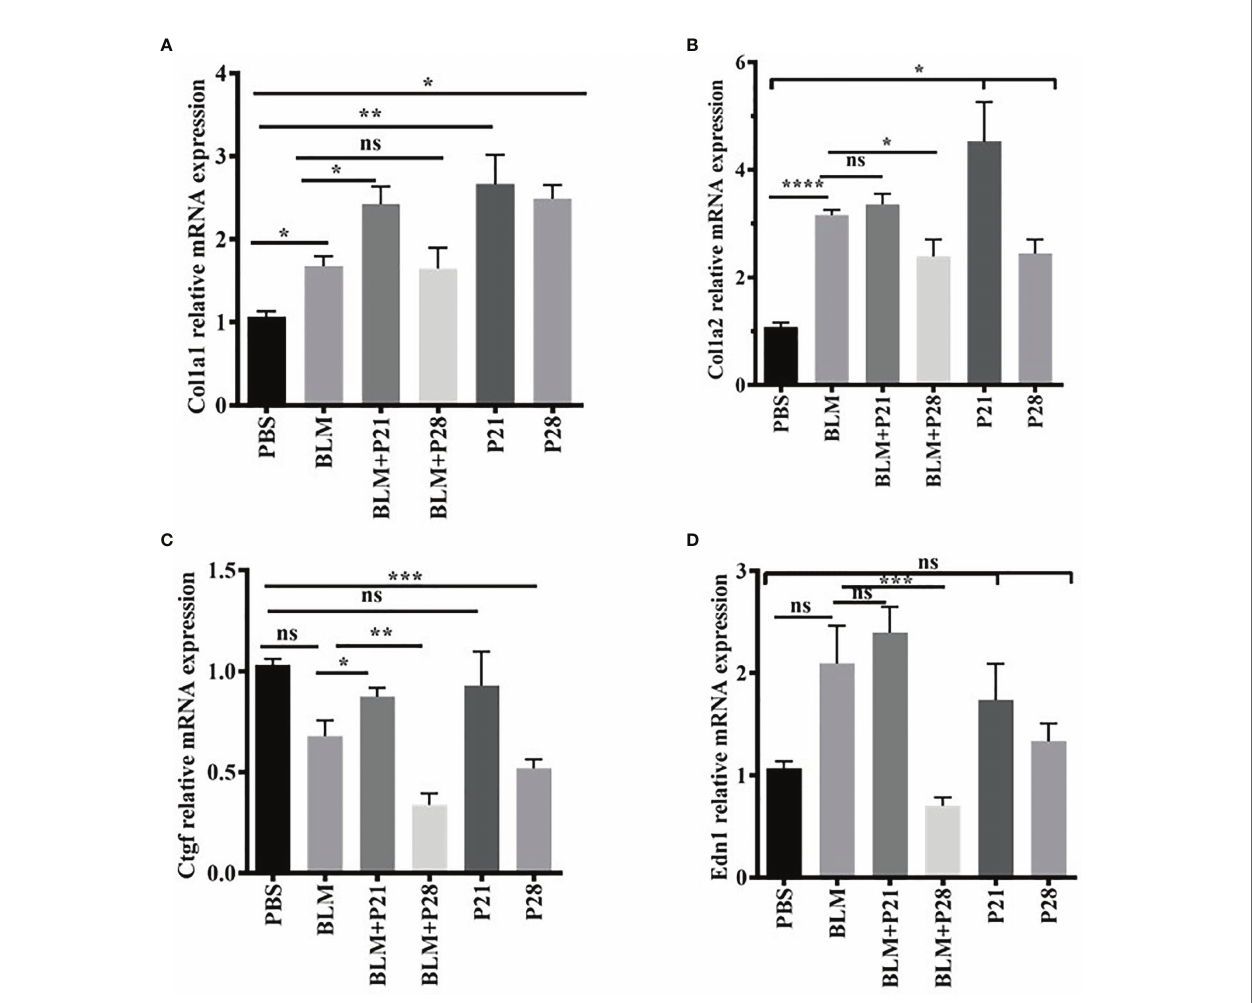
FIGURE 3 | The effect of progesterone on relative gene expression of Col1a1 , Col1a2 , Ctgf , Edn1 . Total RNA was isolated from lung tissues, cDNA was synthesized and quanti fi ed by real – time PCR. (A) Relative expression of Col1a1 in lung tissue. (B) Relative expression of Col1a2 in lung tissue. (C) Relative expression of Ctgf in lung tissue. (D) Relative expression of Edn1 in lung tissue. Results are represented as mean ± SEM, n = 5 mice in each group. Data were analyzed with One – way ANOVA, Tukey multiple comparisons test. BLM, Bleomycin; P, Progesterone; ns, non - signi fi cant, **** = P < 0.0001, *** = P < 0.001, ** = P < 0.01, * = P <